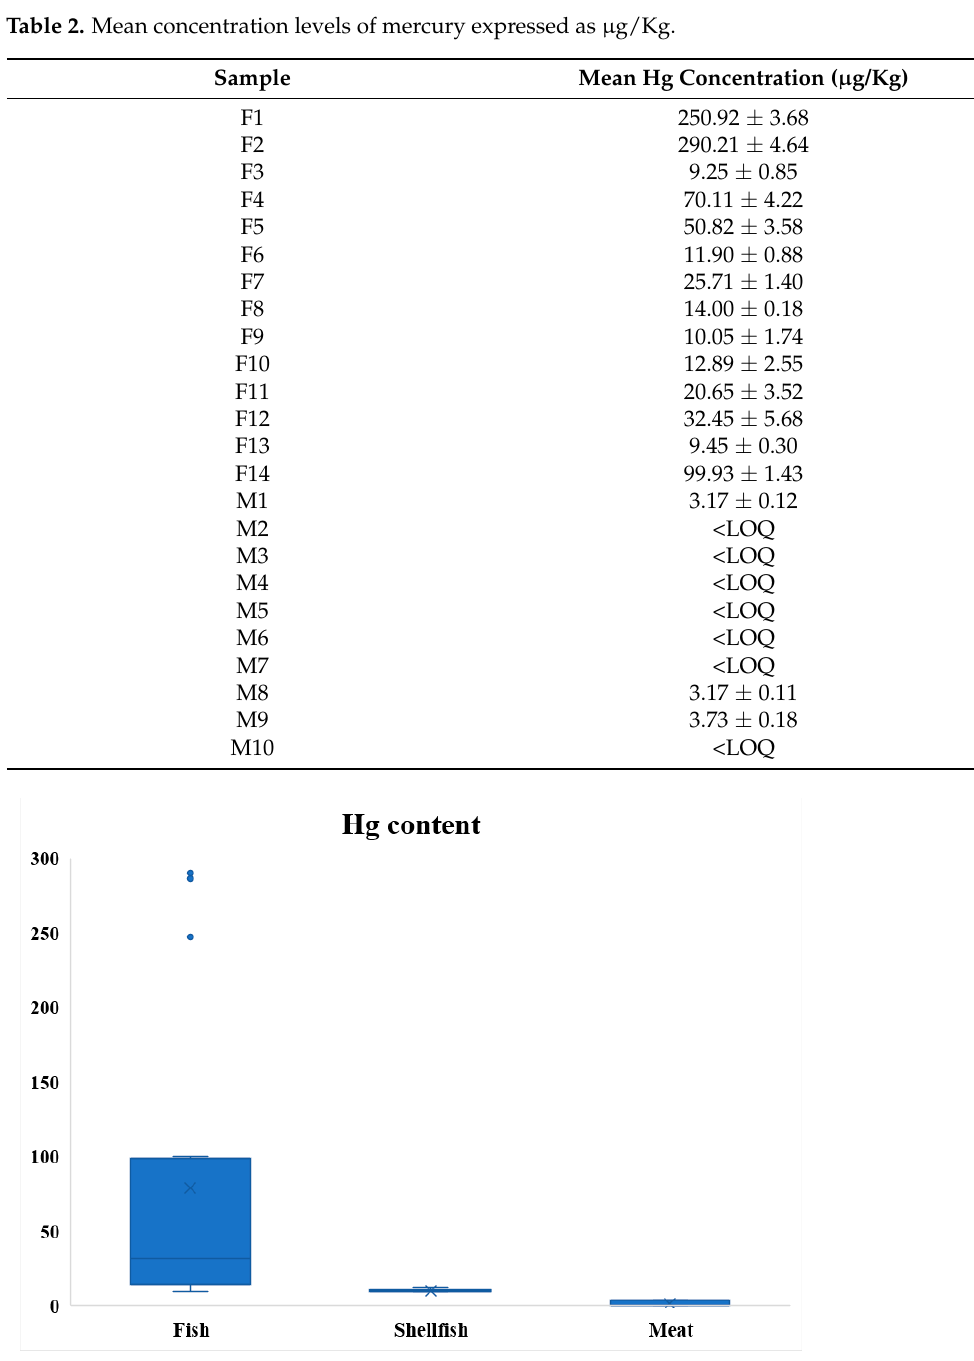
Figure 1. Box plot reporting the variable mercury content in relation to different types of matrices. The “×” indicates the average value of mercury.